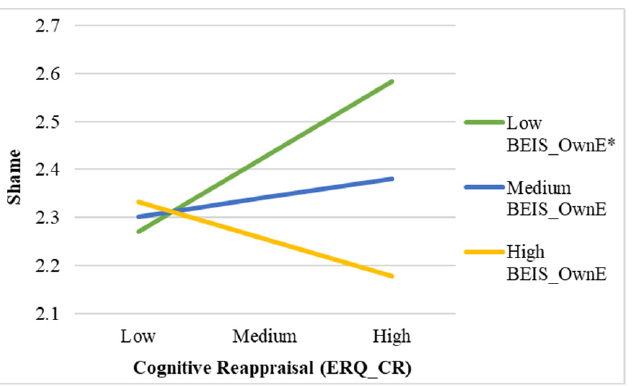
Figure A4. Plot of the relationship between Disgust and Aggressive Reaction on Russia, Ukraine, and Neither Political Alignment; ** = p < 0.01.